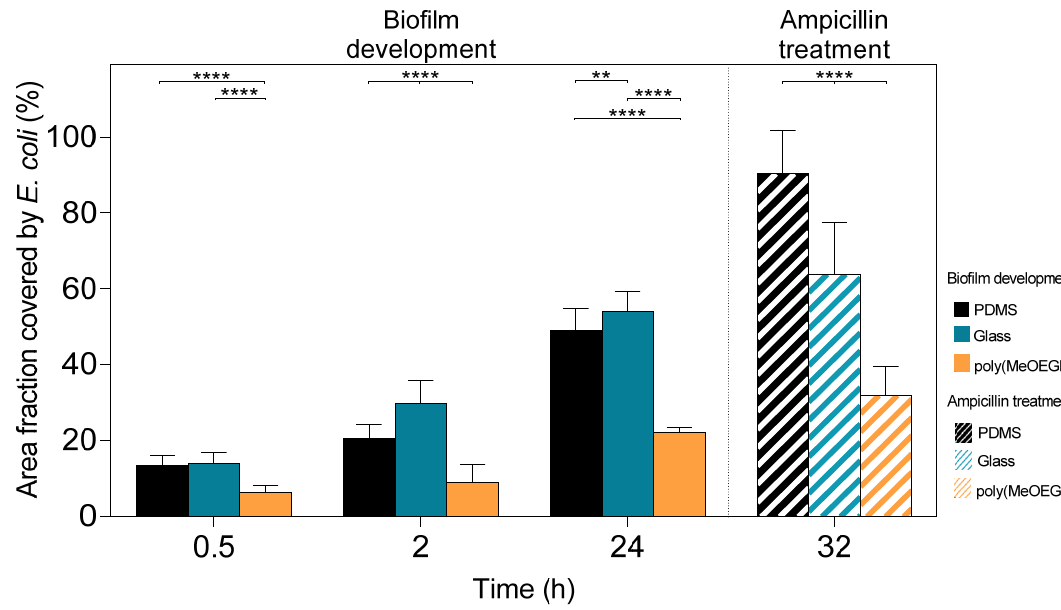
Figure 1. Surface area fraction covered during biofilm development (up to 24 h) and ampicillin treatment for an additional 8 h period (32 h) on polydimethylsiloxane (PDMS) ( ■ and , respectively), glass ( ■ and , respectively), and poly(MeOEGMA) brush ( ■ and , respectively). Standard deviations for three independent samples are presented. Statistical significance for all the surfaces at each time point was determined by one-way ANOVA followed by Tukey’s multiple- comparison test ( **** for P < 0.0001, and ** for P < 0.01).